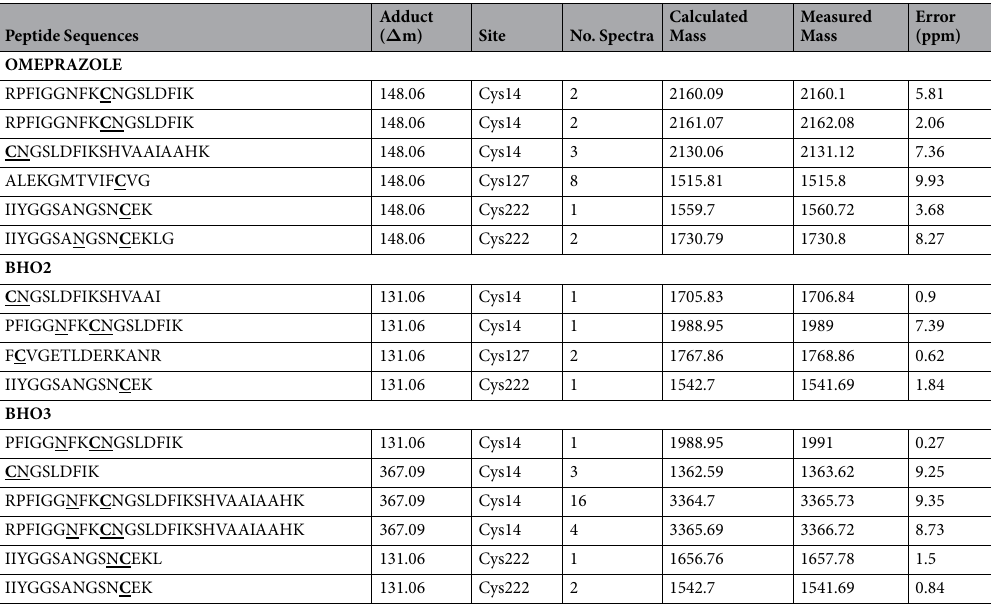
Table 1. Identification of Adducts linked to Cys residues. The modified Cys appears in bold and underlined while the deamidated Asn residues appear underlined. The calculated monoisotopic mass values include the modifications and were calculated by using PeptideMass from ExPASy suite (http://web.expasy.org/peptide_ mass/). The measured monoisotopic mass values were determined from LC-MS/MS data after their analysis with PeptideShaker suite. The error values correspond to the highest value obtained from all spectra for each